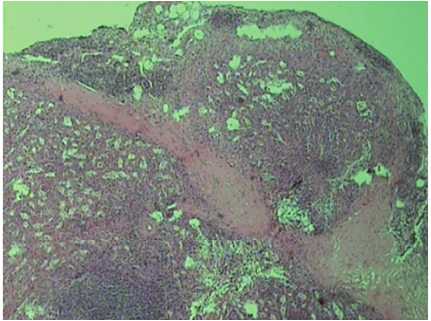
F 4: Nodules of splenic tissue clearly separated by the connec- tive tissue of the